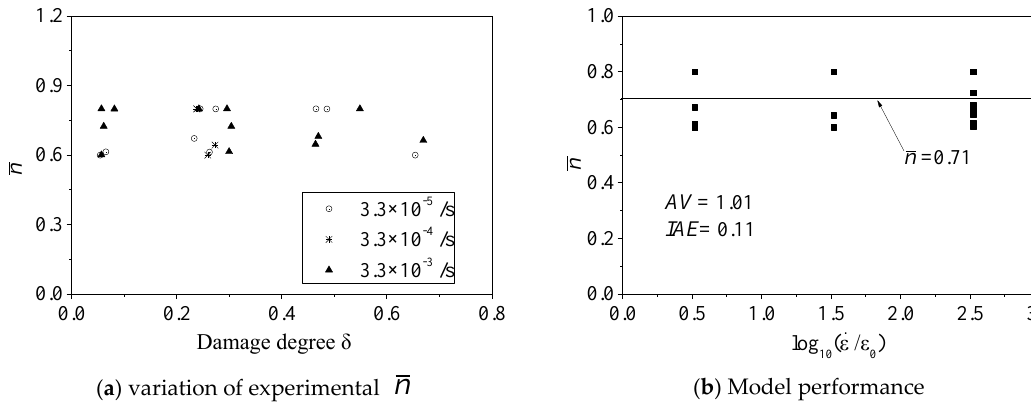
Figure 10. Evaluation of n .